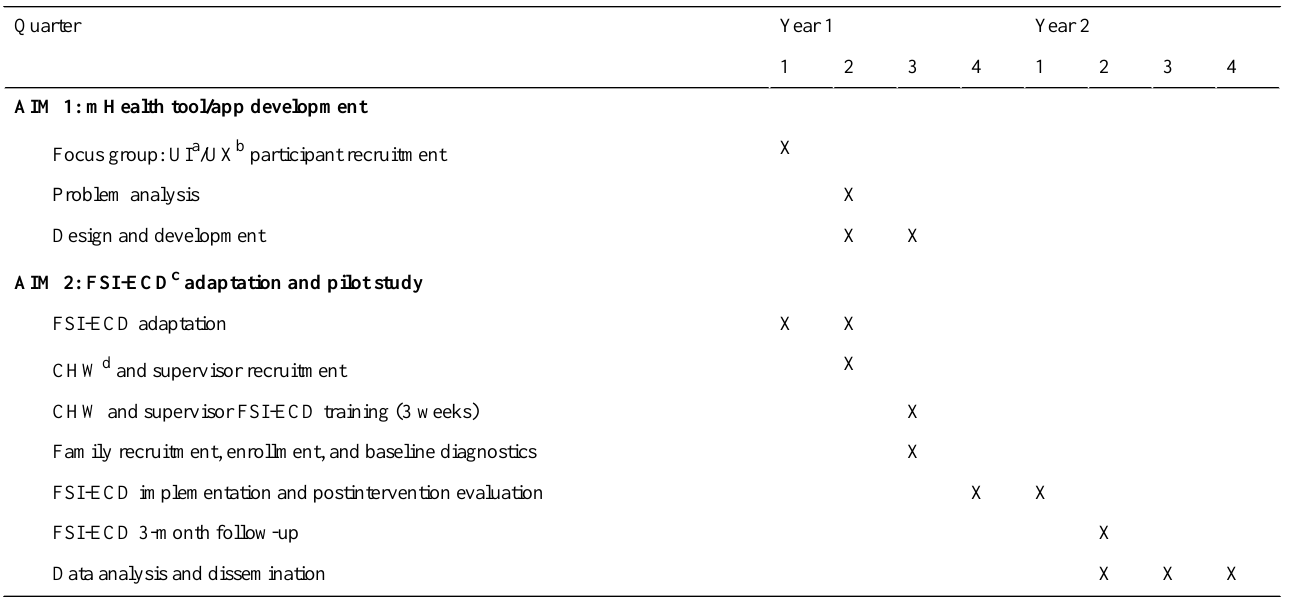
Table 1. Project activities and